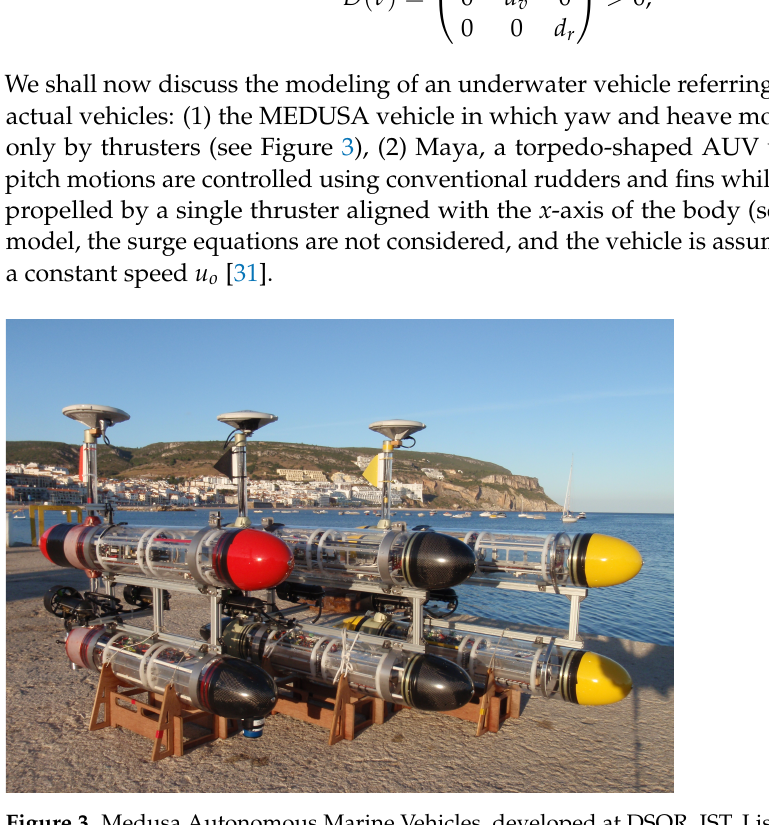
Figure 3. Medusa Autonomous Marine Vehicles, developed at DSOR, IST, Lisbon.